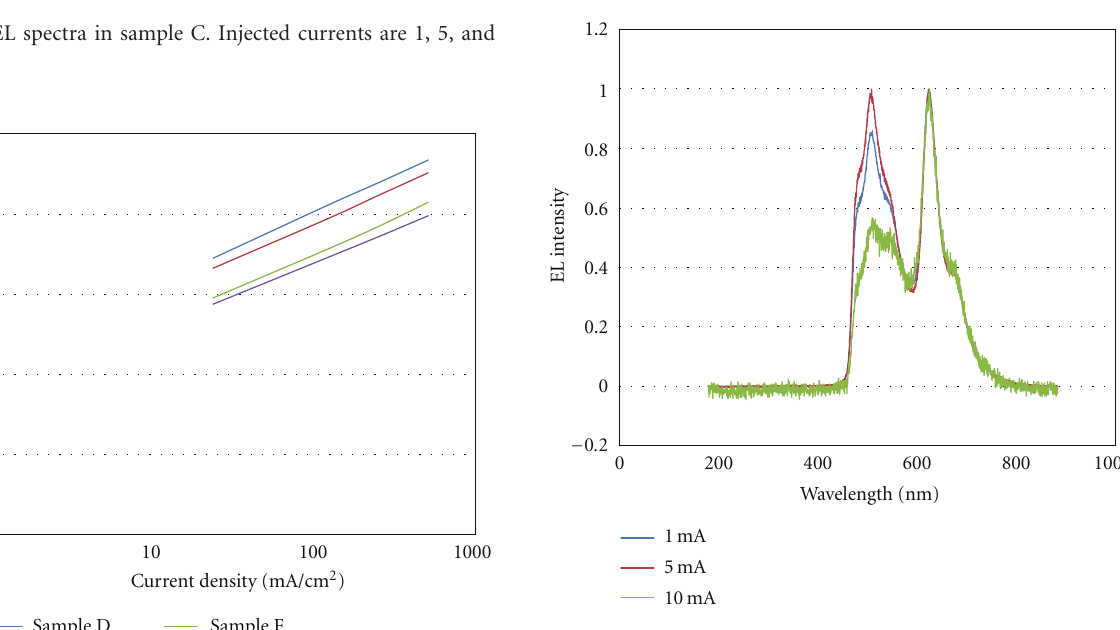
Figure 10: EL spectra in sample D. Injected currents are 1, 5, and